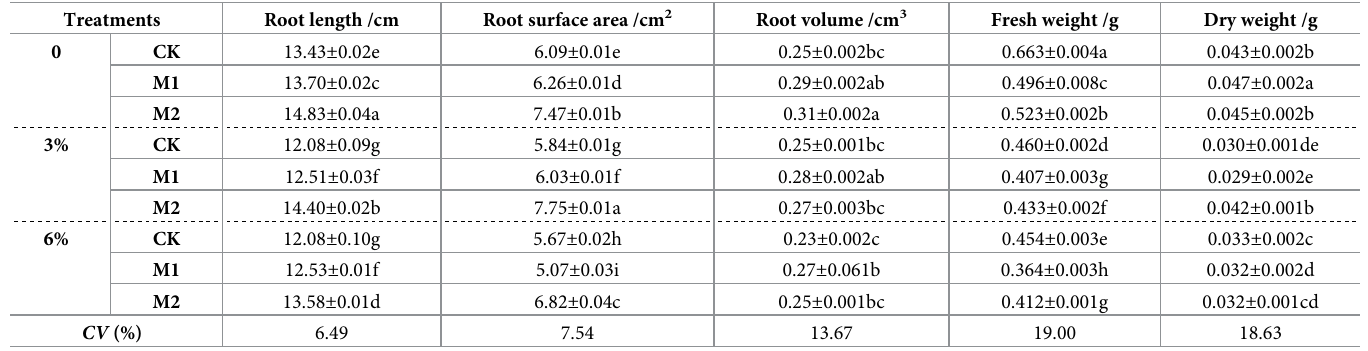
Each value indicated is the means of three replicates recorded ± S.E. Means followed by the same letters are not significantly different at P � 0.05 within the same column. CV: Coefficient of